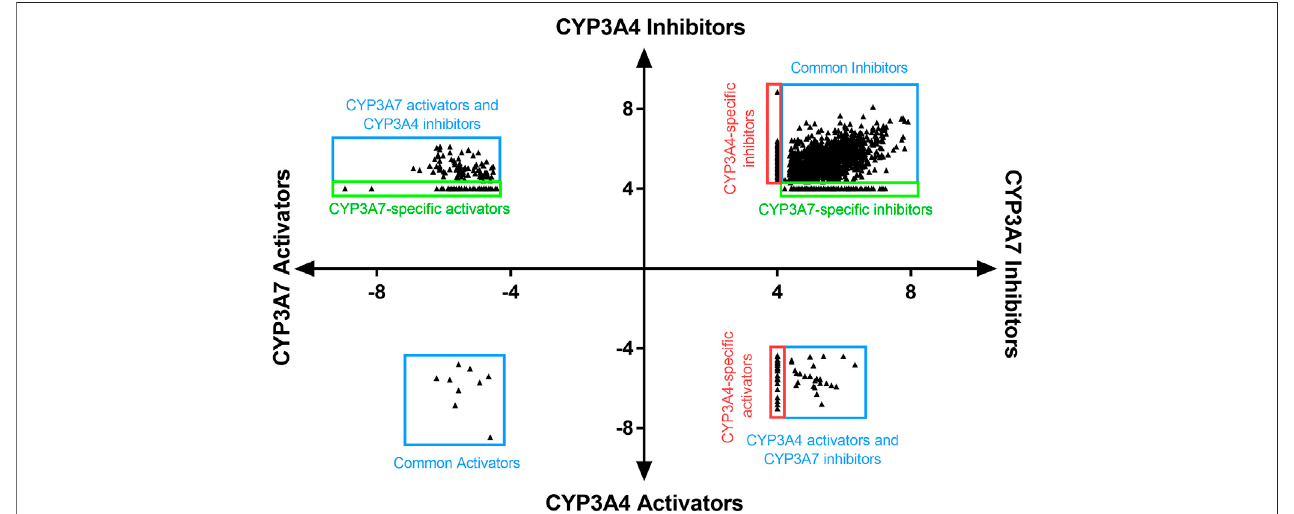
FIGURE 2 | LogIC 50 of CYP3A7 and CYP3A4 hits. Inhibitors are shown as positive logIC 50 and activators are shown as negative logIC 50 . Inactive compounds are shown as logIC 50 of 4 (100 μ M, virtually inactive). Bottom left quadrant hits showed negative IC 50 for both CYP3A4 and CYP3A7 and were categorized as common activators.ToprightquadrantshowscommoninhibitorsintheqHTSGloassay.Topleftandbottomrightarecompoundsthatshownactivationagainstoneenzymeand inhibitionagainsttheother.Boundaryboxes(redorgreenboxes)showenzymespeci fi cobservations(inhibitororactivator-speci fi cbehavior).IfIC 50 wasnotbeable to determined for any enzyme, compounds were excluded from the